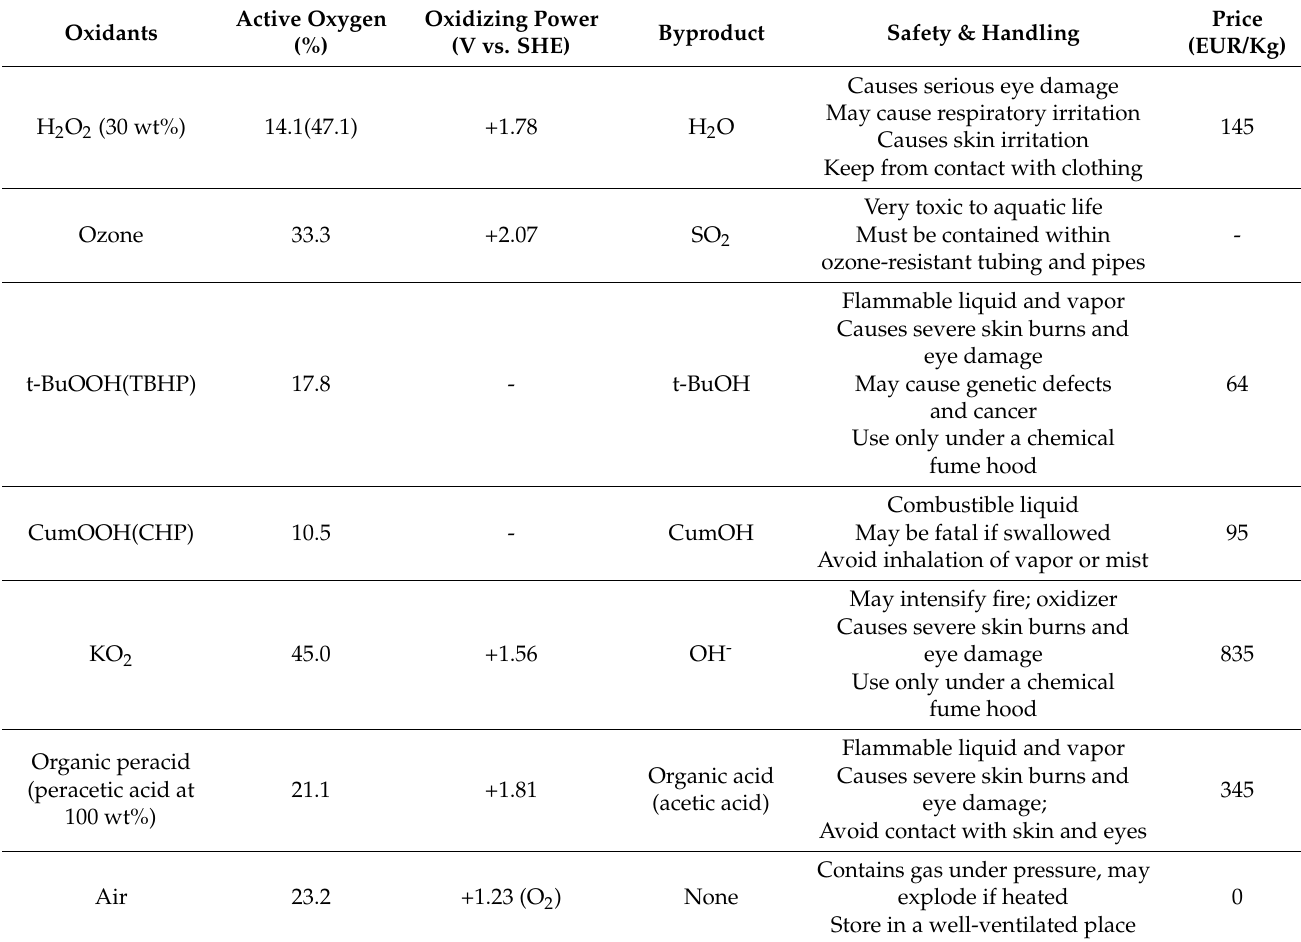
Table 1. Common oxidants and their oxidizing properties in ODS reactions of liquid fuels